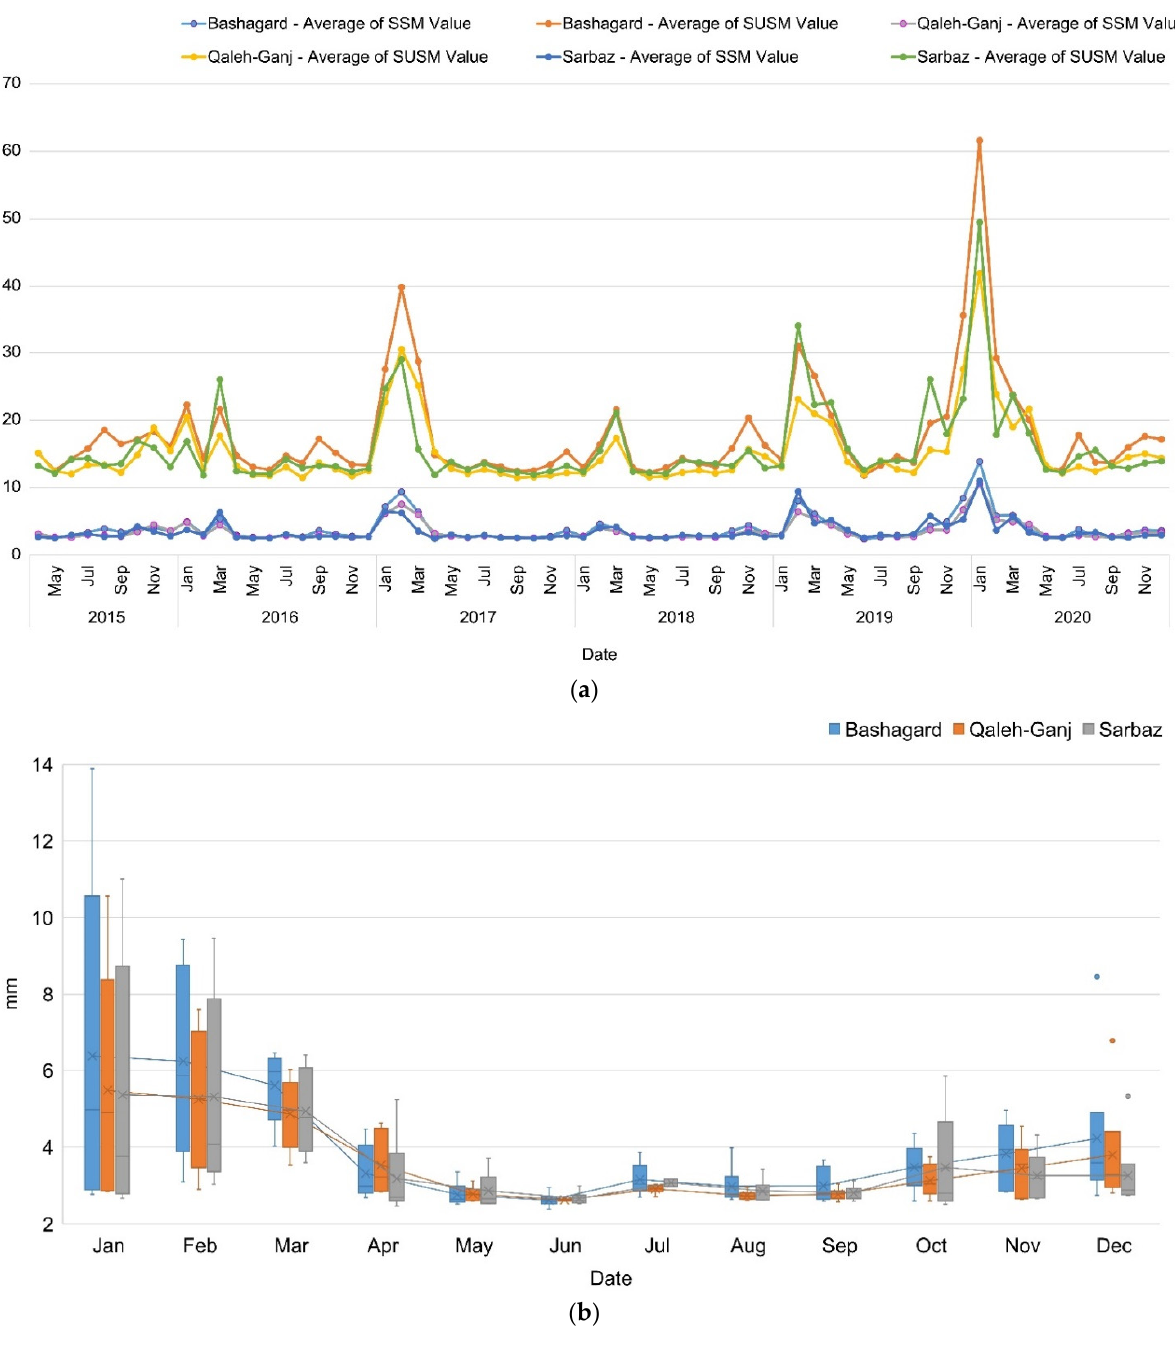
Figure 7. ( a ) Soil moisture time series; ( b ) Box plot of soil moisture time series of Qaleh-Ganj, Sarbaz and Bashagard counties, Iran,